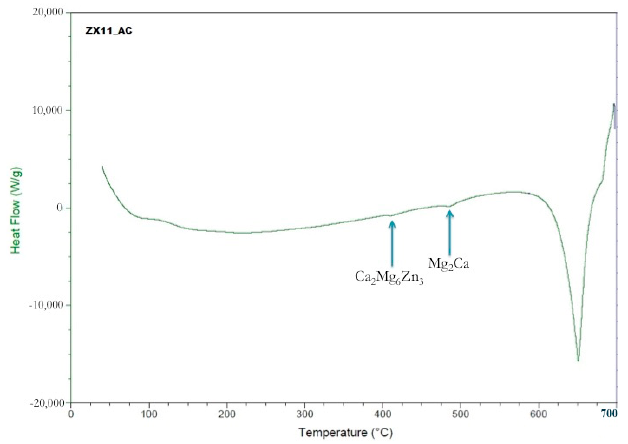
Figure 2. Differential Scanning Calorimetry (DSC) trace of ZX11 alloy showing blimps at 420 °C and 490 °C (shown by arrows) that correspond to the melting of minor phases.